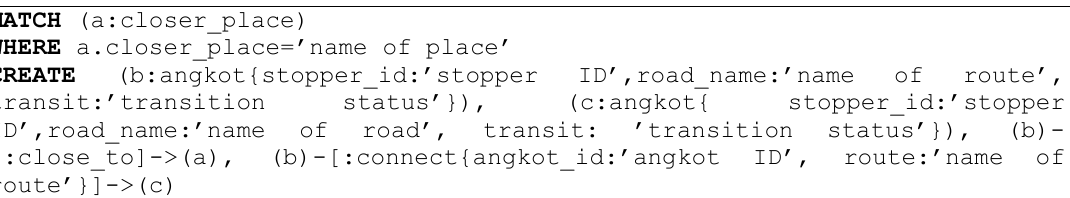
Fig. 6. Cypher query to form relationship.